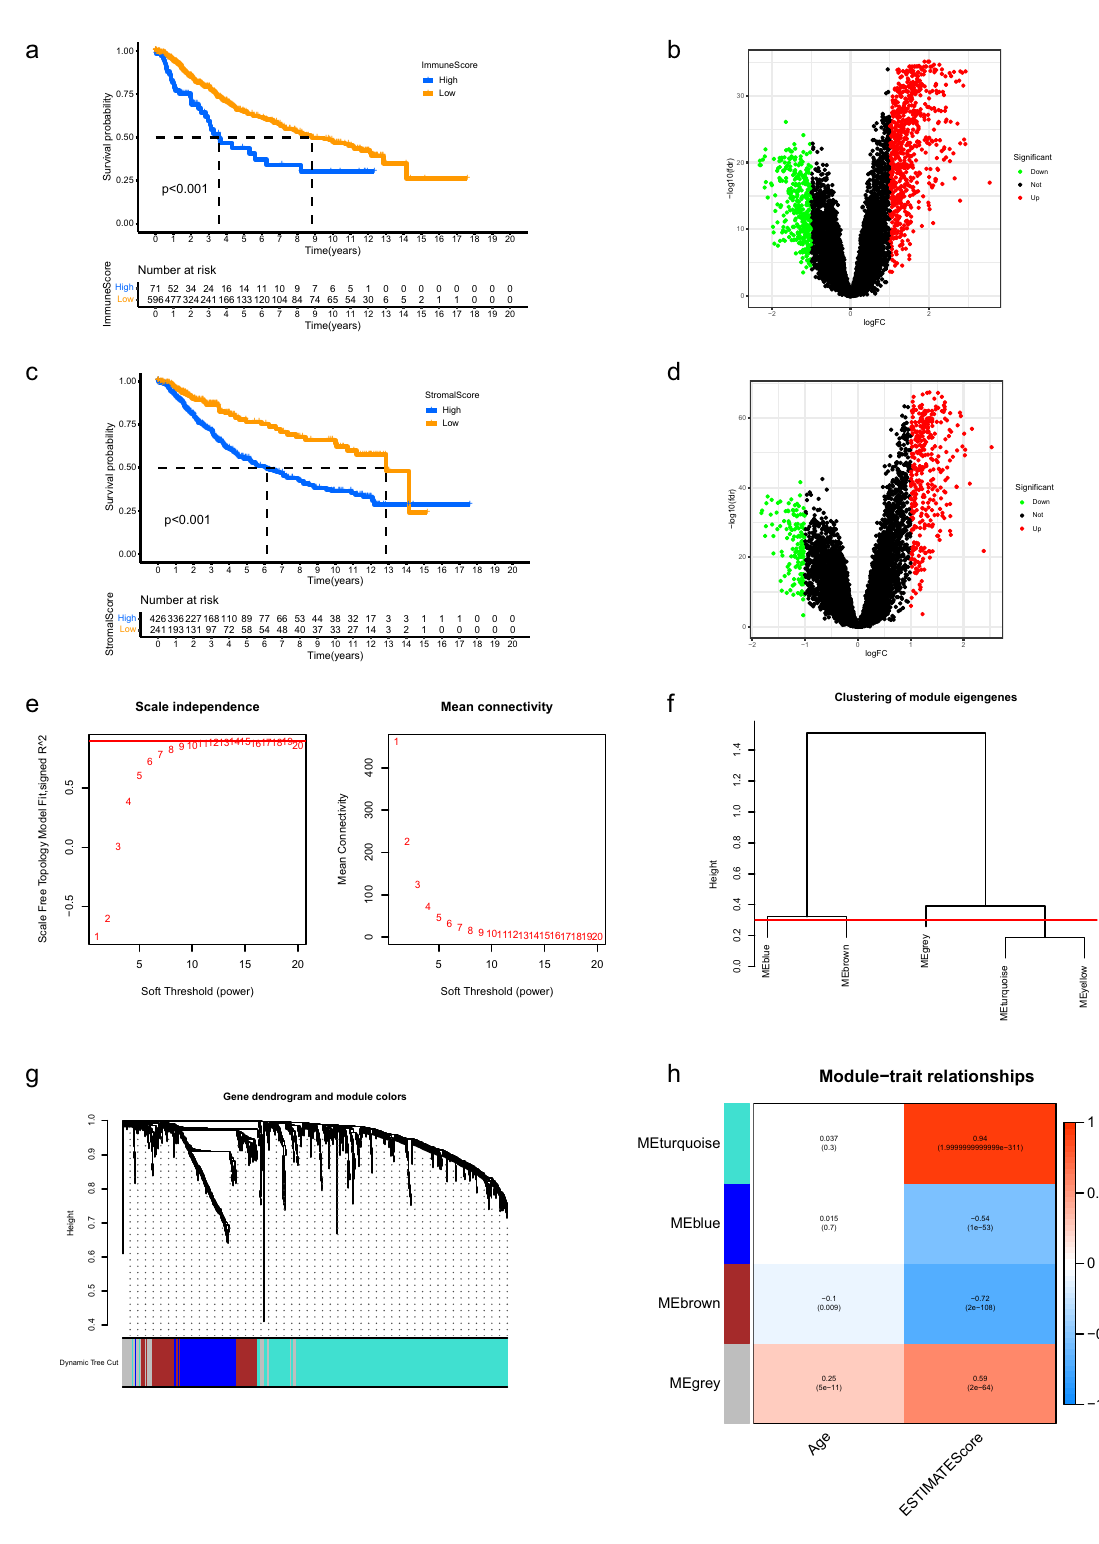
Figure 1. Identification of aging TME related signature. ( a ) Kaplan–Meier analysis revealed that the overall survival of LGG patients in high immune score group was shorter than those in low score group. ( b ) Volcano plots of DEGs between low and high immune score groups. The red dots represented upregulated genes and the green dots represented downregulated genes. The black dots represented genes with no significant difference. ( c , d ) Similar results were obtained between low and high stromal score groups. ( e ) Determination of the scale-independence degree (left) and the mean connectivity index (right) for soft-threshold values ranging from 1 to 20. ( f ) Clustering for the module eigengenes. The cut height was set at 0.30 depicted with the red line. ( g ) Dendrogram of all DEGs and modules with different colors. ( h ) Heatmap showing the key modules which mostly correlated with age and ESTIMATE scores of LGGs. The Pearson correlation coefficients and p values were displayed in cells. TME, tumor microenvironment; LGG, low-grade glioma; DEGs, differentially expressed